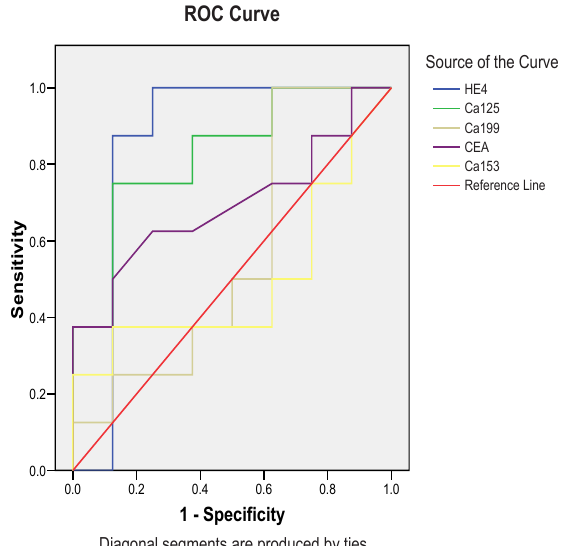
Figure 1. Roc curves of tumor